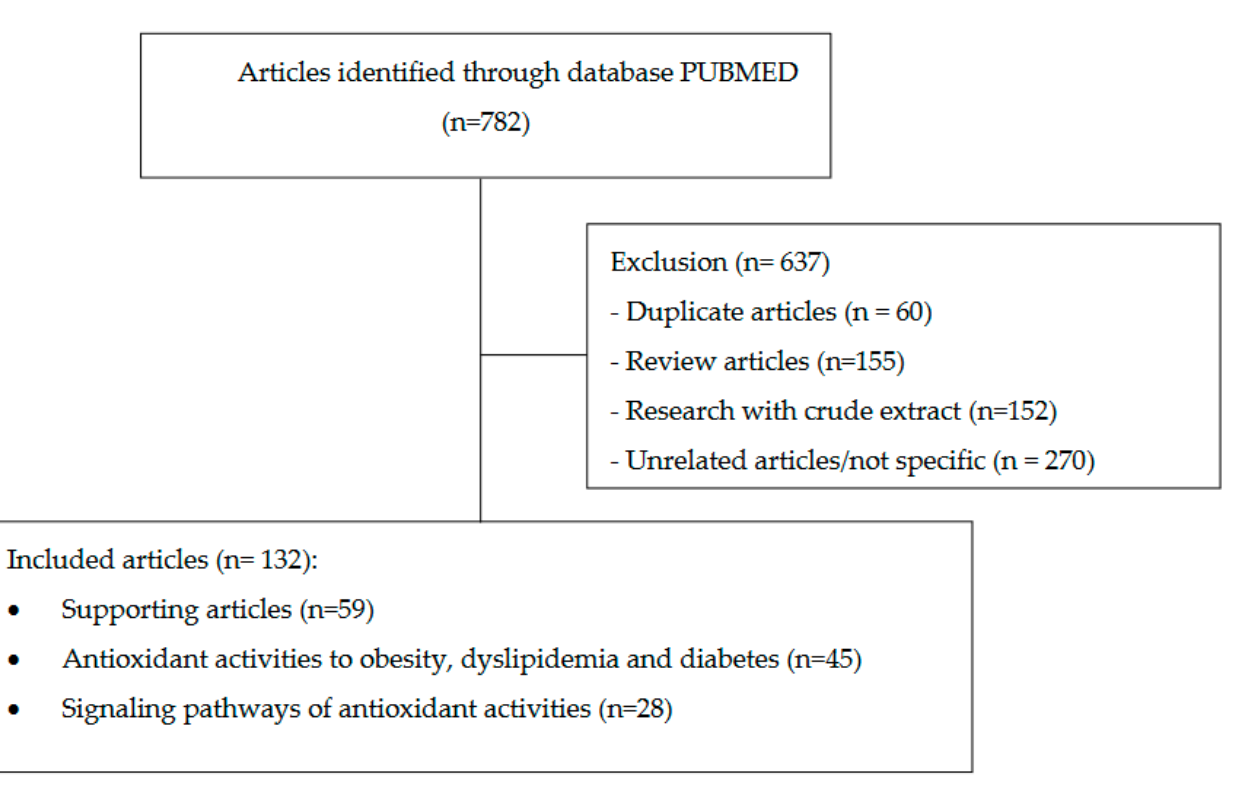
Figure 1. Article literature search flow chart.